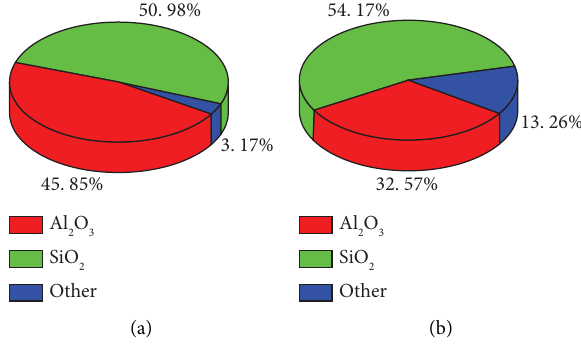
Figure 10: XRF patterns of MK (a) and GRS (b).